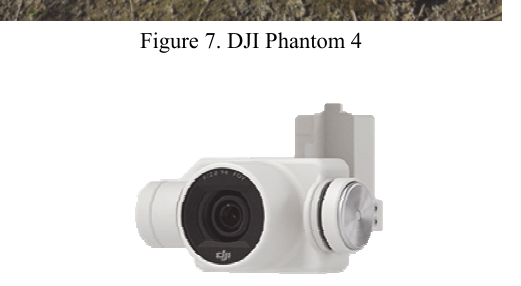
Figure 8. DJI Phantom 4 dedicated onboard